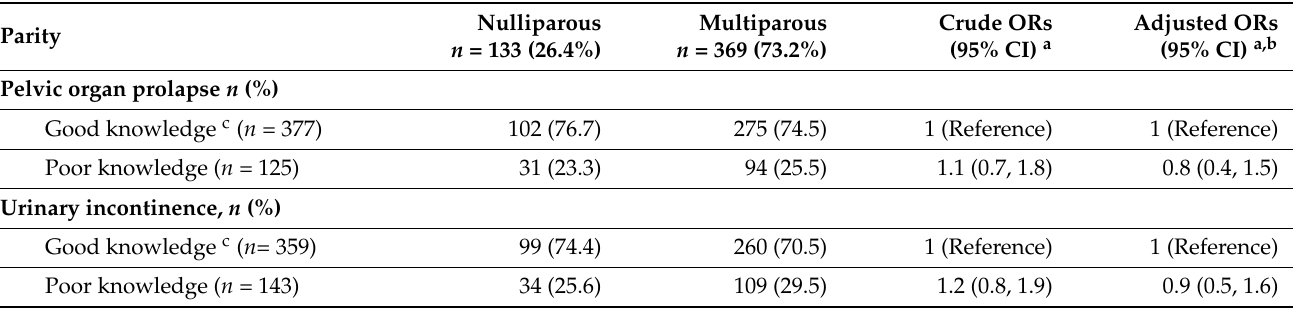
Table 2. Associations between knowledge of pelvic organ prolapse, urinary incontinence, and parity for pregnant women in Gondar, Ethiopia. n =